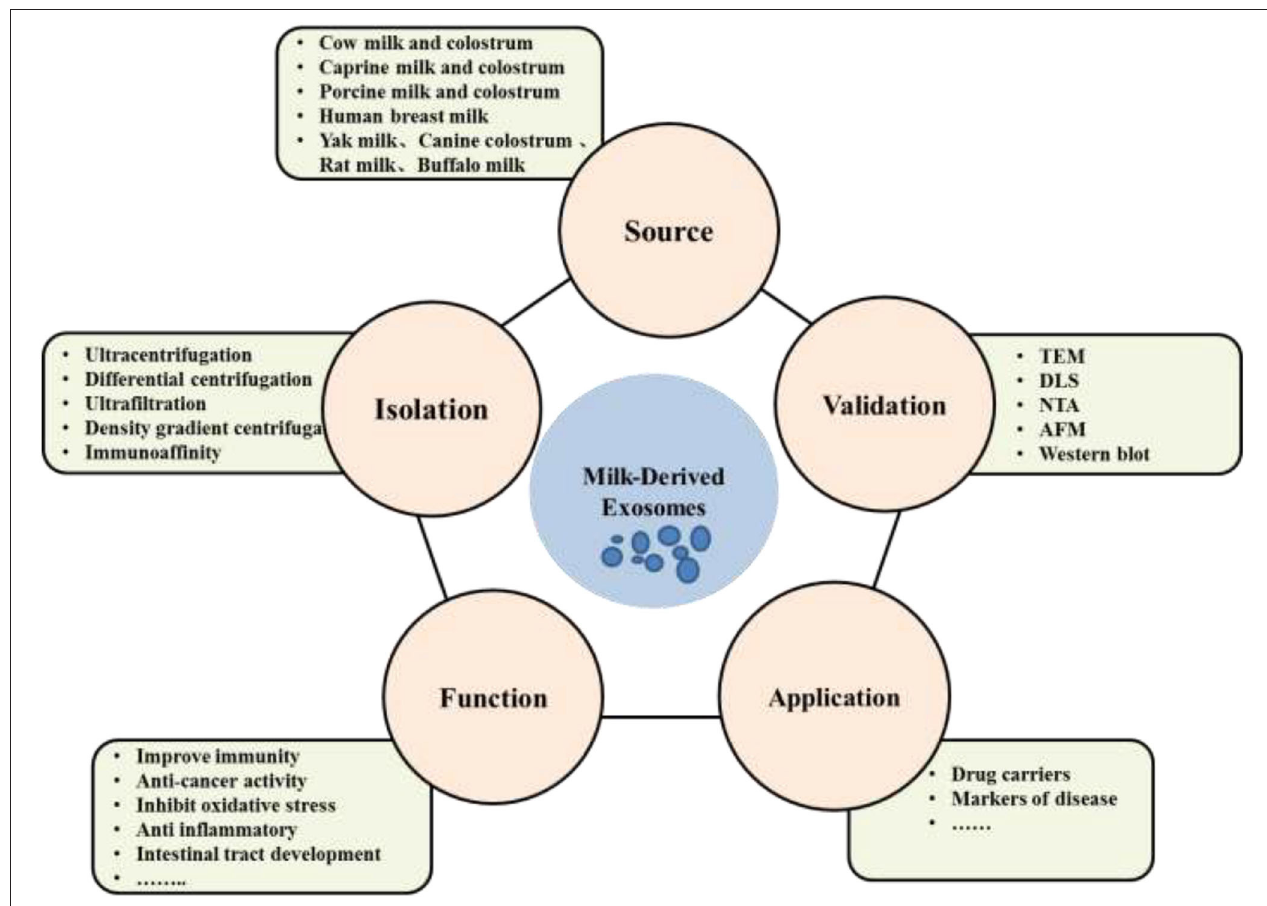
FIGURE 1 | Sources of milk derived exosomes, isolation and validation methods, functions as well as